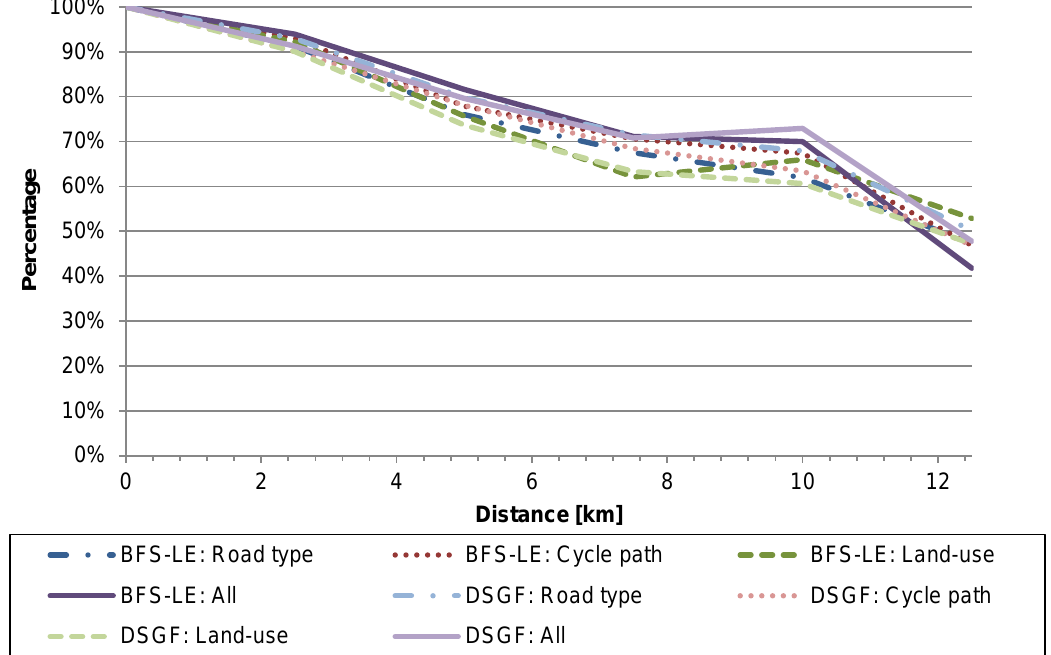
Figure 3. Average maximum coverage over